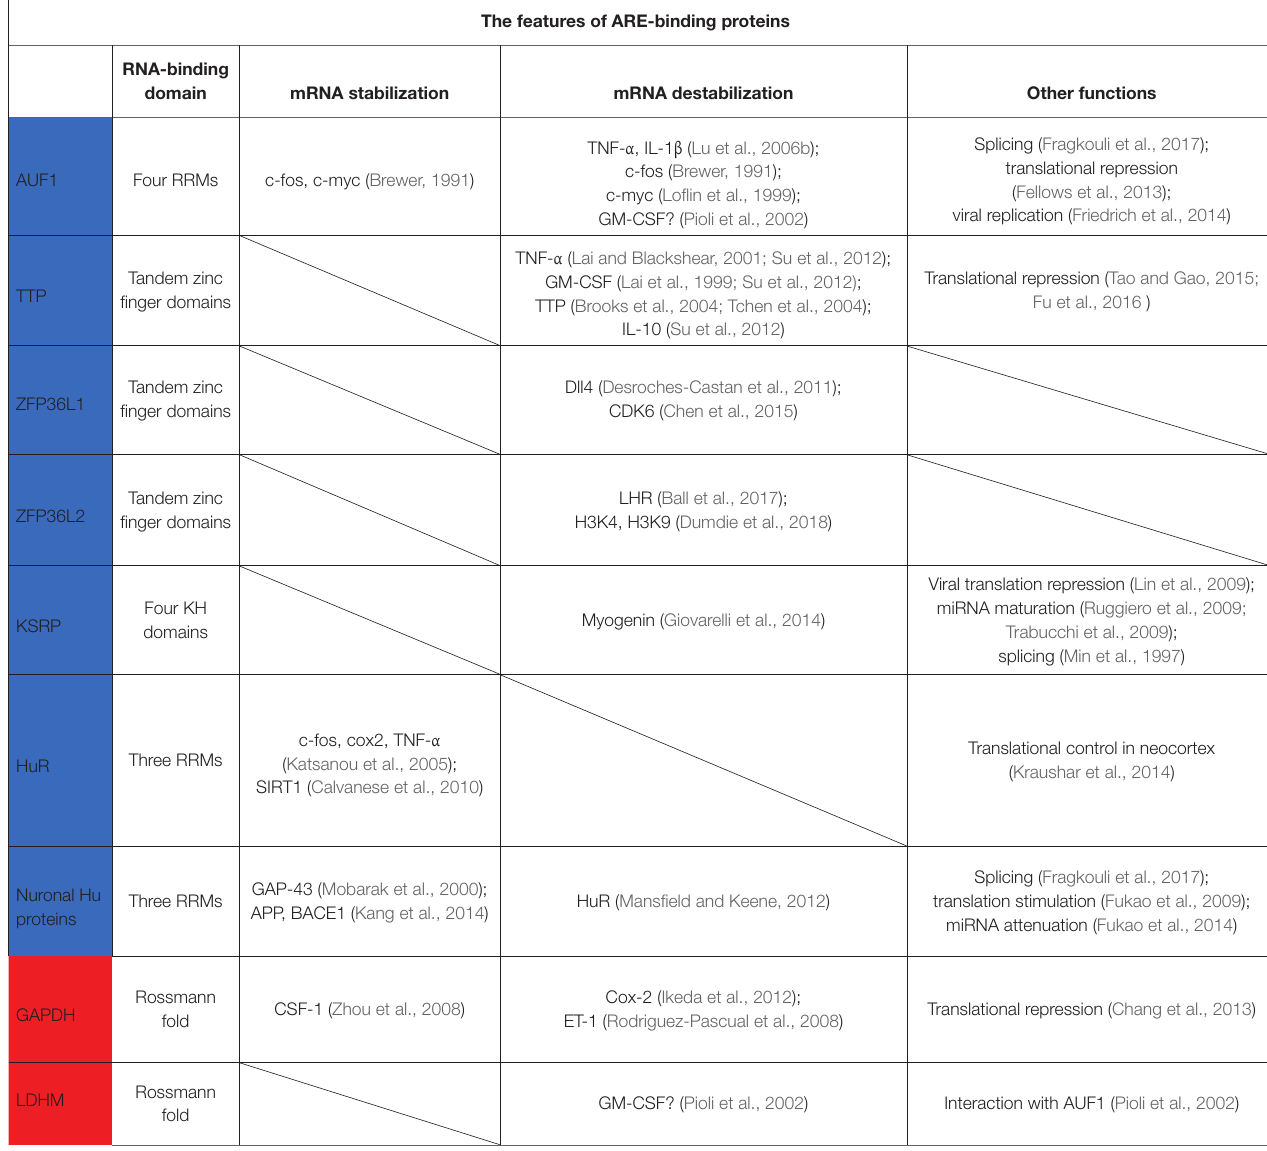
TABLE 1 | The RBDs, targets, and functions of ARE-BPs in this review. RNA-binding